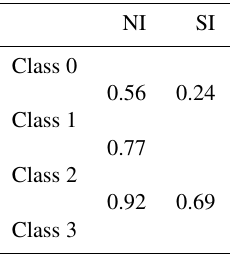
Table 1. Threshold values for the narrowing (NI) and sinuosity (SI) indices, as determined by the K-means